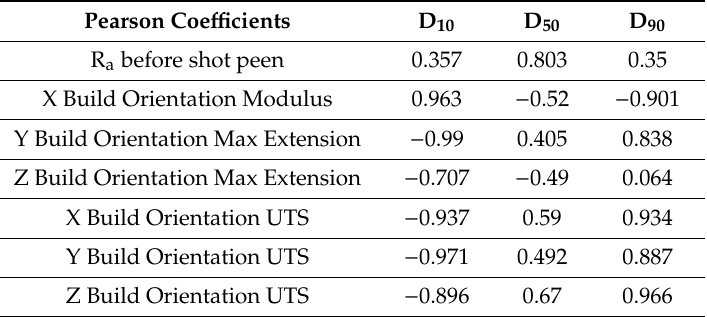
Table 7. Pearson correlation calculation examining the dependency of surface roughness and tensile strength on powder particle